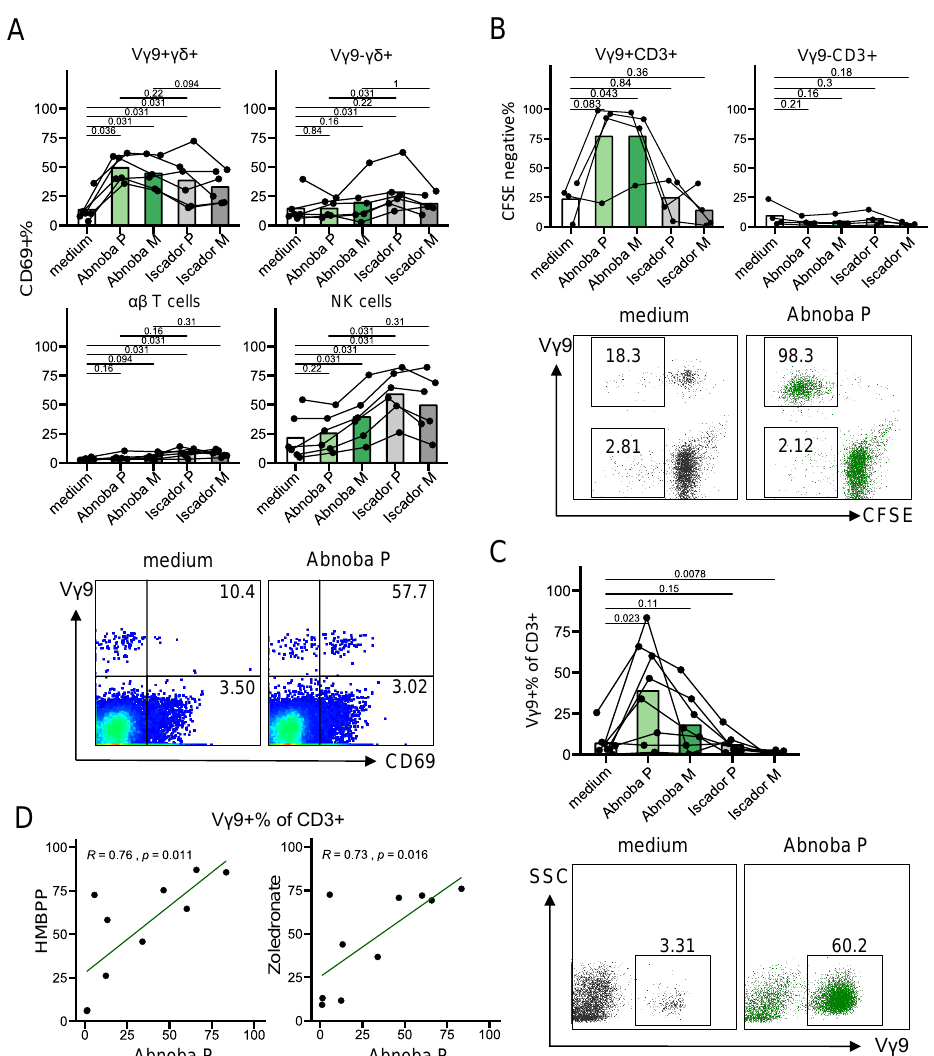
Figure 1. AbnobaViscum but not Iscador mistletoe extracts induce specific expansion of Vγ9Vδ2 T cells. ( A ) Percentage of CD69 expression on different cell types after stimulation with different mistletoe extracts for 1 day. Upper left: Vγ9+ γδ T cells (CD3+γδ+Vγ9+); upper right: Vγ9 - γδ T cells (CD3+γδ+Vγ9 - ); lower left: αβ T cells (CD3+γδ -); lower right: natural killer (NK) cells (CD3-CD56+). Lines connect the same subjects ( n = 6), bars indicate mean values. Values on the graphs indicate p values (obtained with the Wilcoxon signed-rank test). Bottom panels show representative flow cytometry plots (gated on CD3+ T cells), numbers indicate percentages of CD69+ cells, expressed as a percentage of Vγ9+CD3+ cells (top) and as a percentage of Vγ9 -CD3+ cells (bottom). ( B ) Percentage of CFSE- negative Vγ9+ T cells (CD3+Vγ9+, upper left) and Vγ9 - T cells (CD3+Vγ9 -, upper right) after stimulation for 5 days with different mistletoe extracts. Lines connect the same subjects ( n = 4), bars indicate mean values. Values on the graphs indicate p values (obtained with the paired T-test). Bottom panels show representative flow cytometry plots (gated on CD3+ T cells), numbers indicate percentages of CFSE-negative cells , expressed as a percentage of Vγ9+CD3+ (top) and as a percentage of Vγ9 -CD3+ (bottom). ( C ) Percentage of Vγ9+ cells (of total CD3+ T cells) after stimulated with different mistletoe extracts for 7 days. Lines connect the same subjects ( n = 8), bars indicate mean values. Values on the graphs indicate p values (obtained with the Wilcoxon signed-rank test). Bottom panels show representative flow cytometry plots (gated on CD3+ T cells), numbers indicate percentages of positive cells in the indicated gates. ( D ) Correlation between AbnobaViscum P- and HMBPP-, and zoledronate-induced expansion (7 days). Each dot represents one subject ( n = 10).